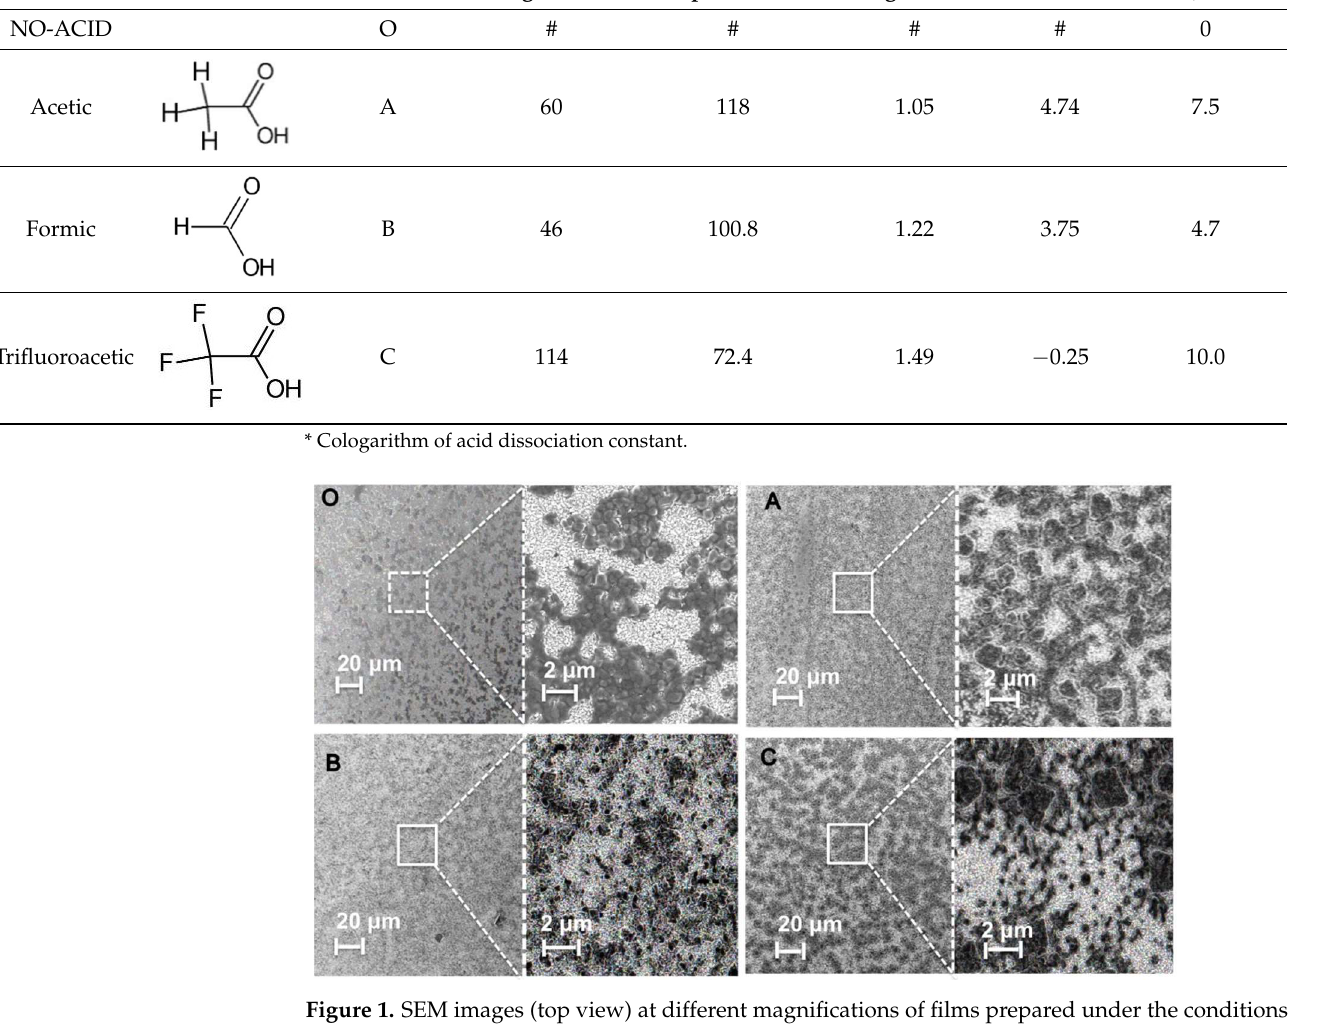
Figure 1. SEM images (top view) at different magnifications of films prepared under the conditions reported the Materials & Methods section. The films are named O (no acid additive), A (acetic acid), B (formic acid), C (trifluoracetic acid).